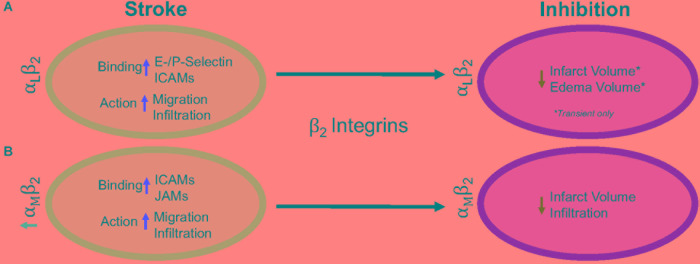
Representative image of the β2 integrin response following experimental stroke and inhibitory antibody treatment in preclinical trials. Inhibition of (A) αLβ2 and (B) αMβ2 integrins post-stroke responses and effects.